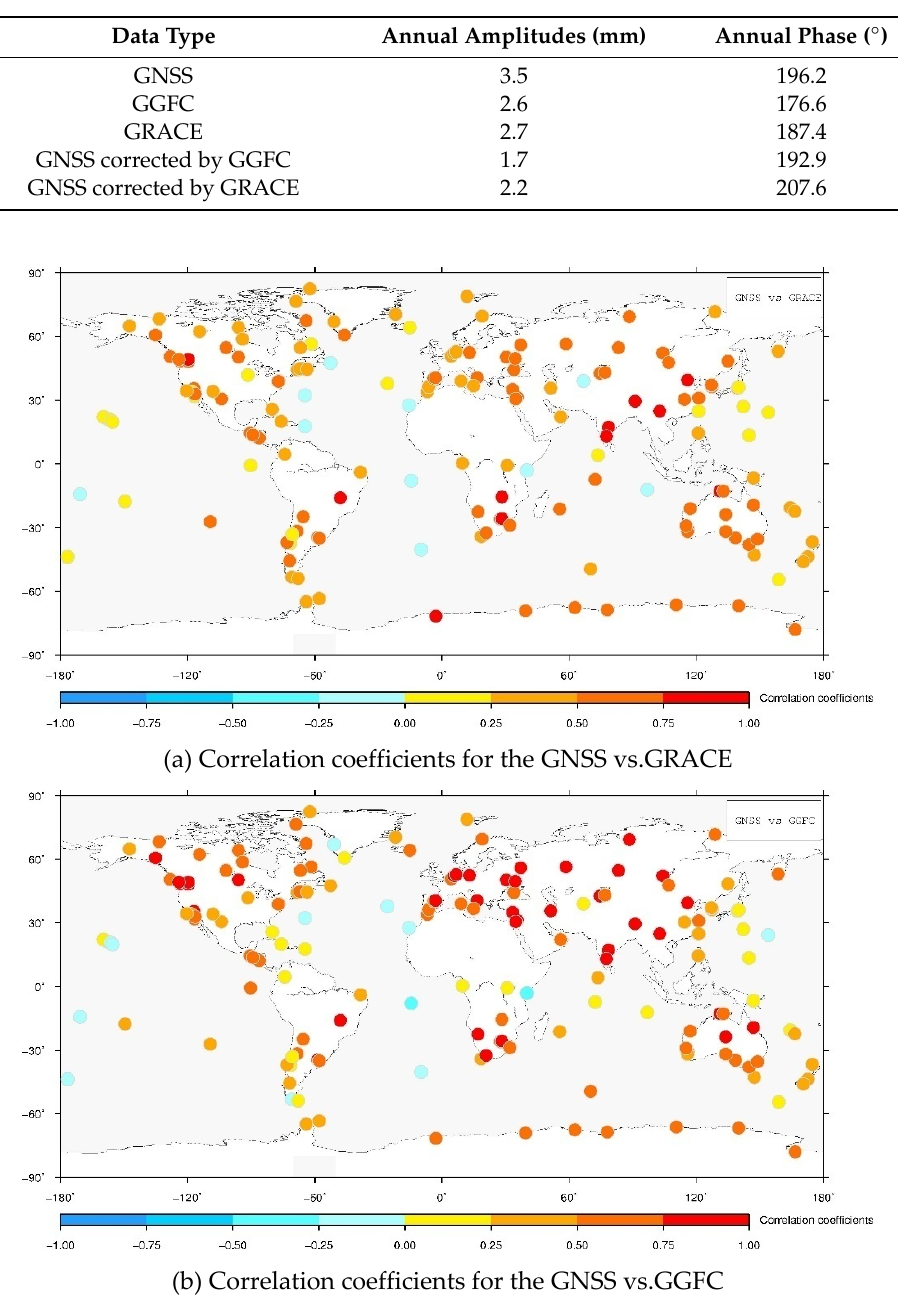
Figure 4. Correlation coefficients for the GNSS vs. GRACE (upper panel) and GNSS vs. GGFC (bottom panel) time series.